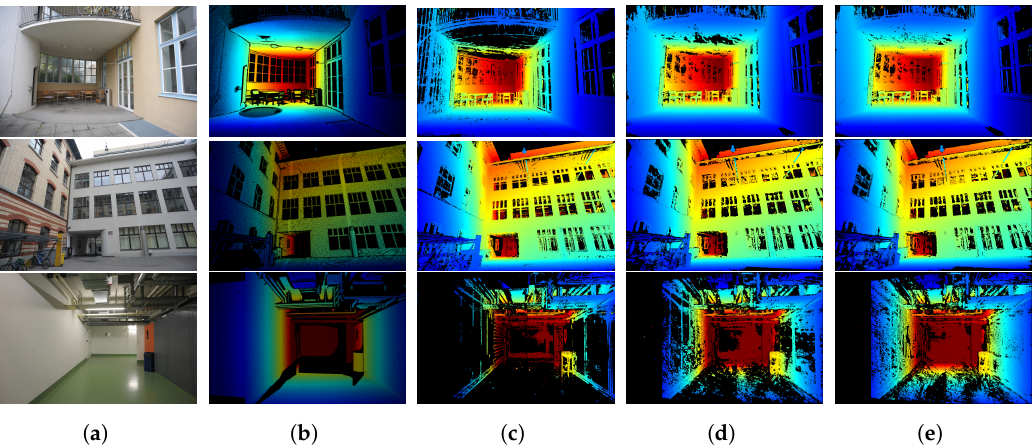
Figure 5. Qualitative depth map comparison of our method with other state of the art algorithms for the ETH3D benchmark sequences terrace , courtyard , and pipes . Labels for walls and ceilings have been used in our method to improve the depth estimation. GT depth maps look sparse as they contain empty pixels [3]. All other depth maps are scaled to the GT color